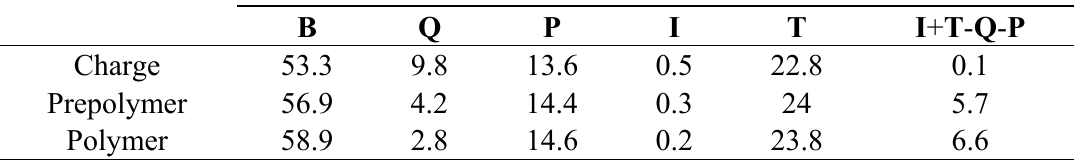
Table 1. Mole % before and after prepolymerization and polymerization (averages of 9 samples of varied